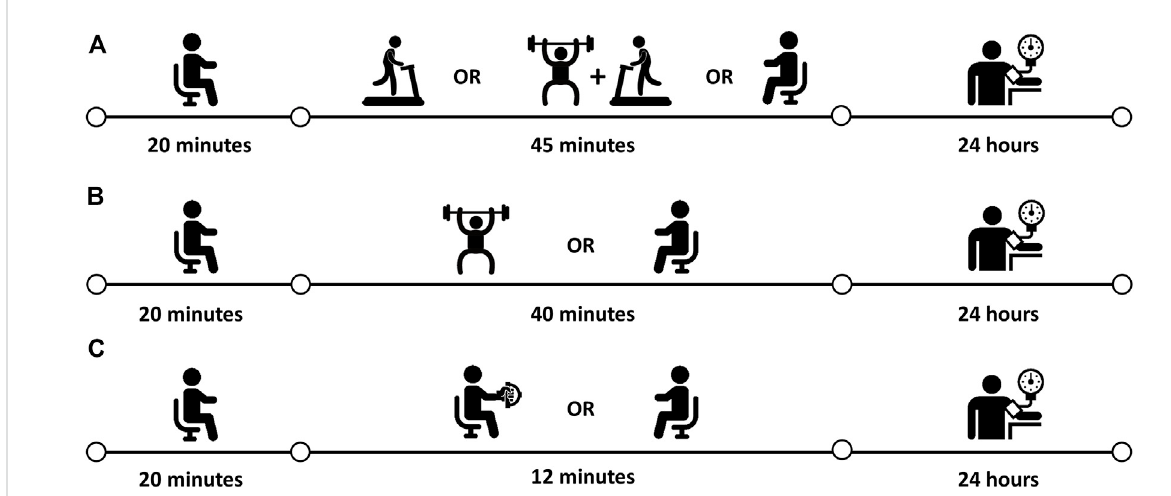
FIGURE 1 Experimental design and protocol. (A) Ferrari et al. (2017) – aerobic, combined e control sessions; (B) Schimitt et al. (2020) – resistance and control sessions; (C) Bertoletti et al. (2022) – isometric handgrip and control